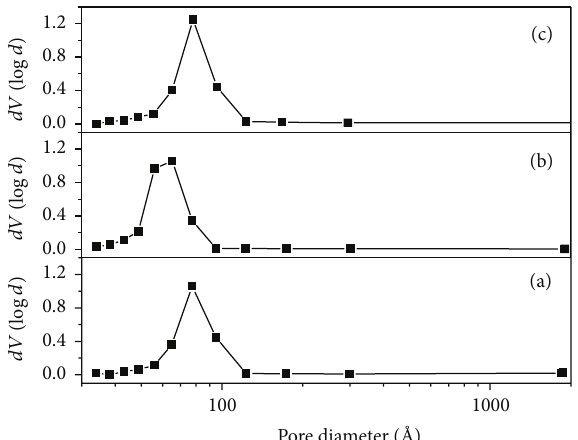
Figure 9: The BJH pore size distribution graphs of synthesized TiO 2 nanoparticles: (a) 0% AC, (b) 5% AC, and (c) 10% AC.